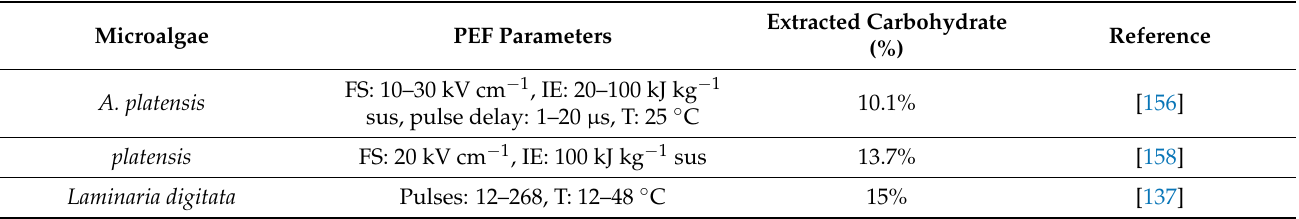
Table 6. Effect of the parameter variation of PEF on carbohydrate extraction. T: temperature; FS: field strength; IE: input